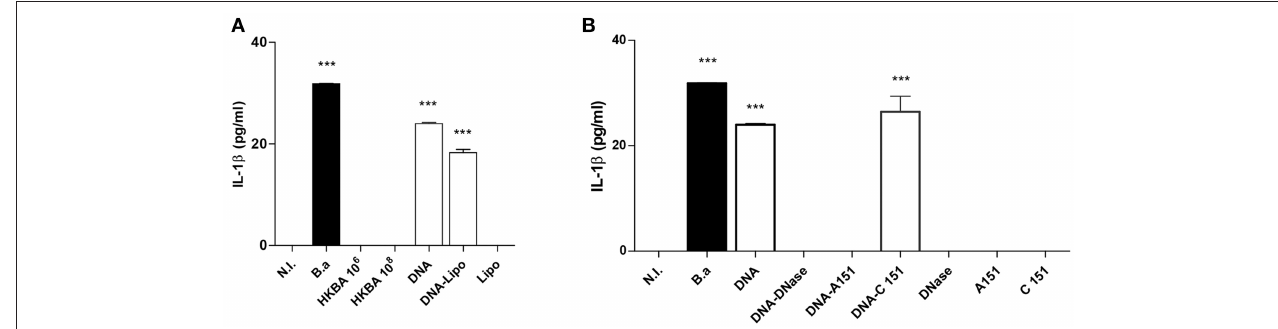
FIGURE 3 | DNA from B. abortus induces IL-1 β . (A) LX-2 cells were infected with B. abortus ( B.a ) at MOI 1000 or treated with heat-killed B. abortus (HKBA) (1 × 10 6 and 1 × 10 8 bacteria/ml), 2 µ g/ml of DNA, DNA and lipofectamine (DNA + Lipo), and lipofectamine alone as control (Lipo); IL-1 β secretion was measured in culture supernatant after 24h by ELISA. Determination of IL-1 β in culture supernatants from LX-2 cells treated with DNA, DNA and A151, DNA and C151 as control, DNA treated with DNAse I, and DNAse I alone as control (B) . Data are given as the means ± SD from at least three individual experiments. *** P < 0.001 vs. non-infected cells (N.I.).